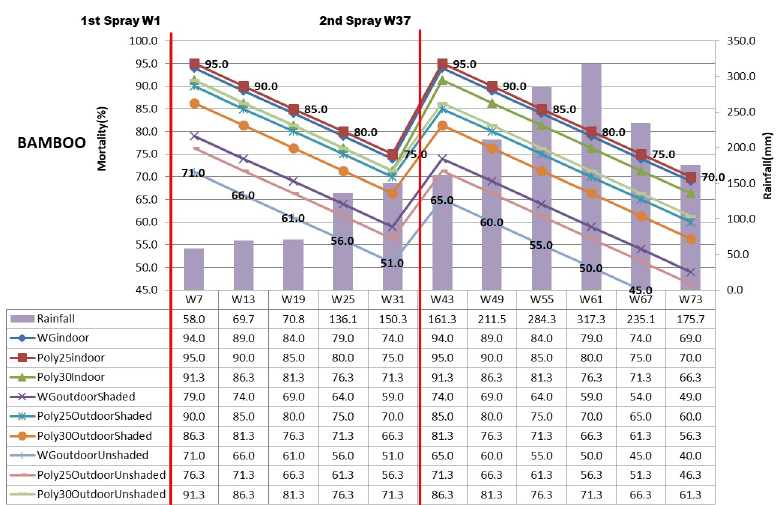
Fig 4. Mortality rate (%) based on location, insecticide, bamboo wall and